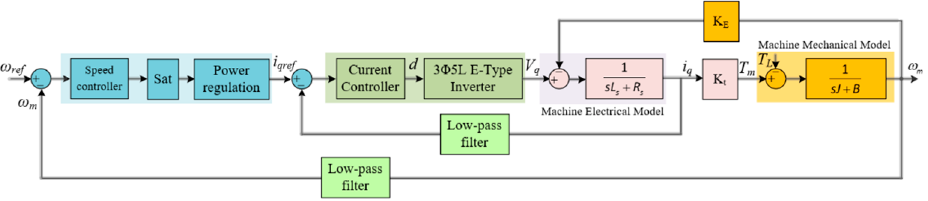
Figure 13. Schematic of the control loop used to achieve the control tuning of the 3 Φ 5L E-Type Inverter.